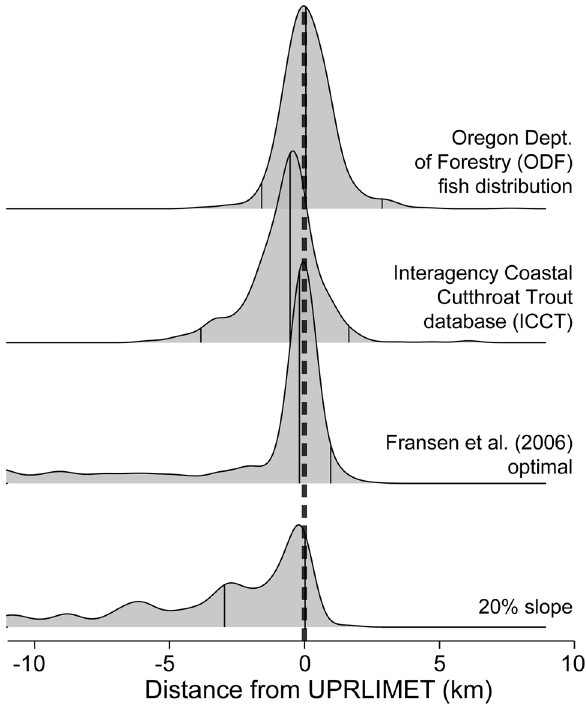
Figure 6. Ridge plots of frequency distributions of distances to the upper trout limit for UPRLIMET compared to trout occurrence and habitat distributions from Oregon Department of Forestry (ODF), trout occurrence distributions from the Interagency Coastal Cutthroat Trout (ICCT) database, Fransen et al. (2006) optimal model 13 , and 20% slope cutoff for western Oregon. Positive numbers represent overestimation relative to UPRLIMET and negative numbers are an underestimation. Note that the previously used estimates for upper trout limit by Fransen et al. (2006) optimal 13 , a 20% slope, and the ICCT database are biased towards underestimation and ODF overestimates. X-axis is distance to UPRLIMET in kilometers, and y-axis is relative